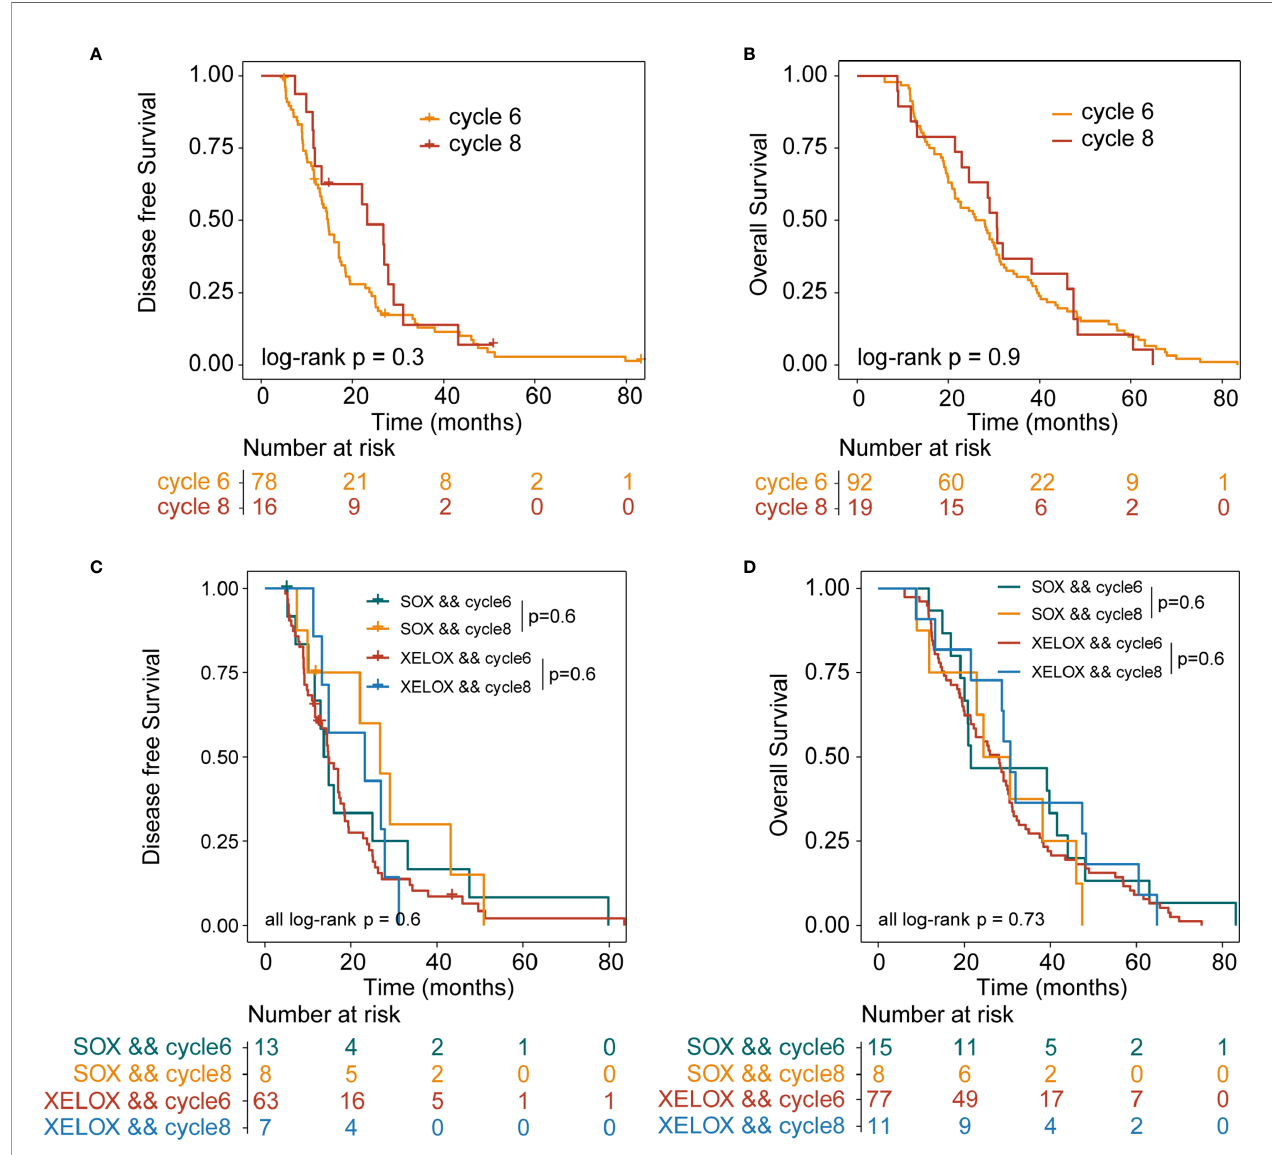
FIGURE 3 | Kaplan-Meier survival curves for disease-free survival (DFS) and overall survival (OS). DFS (A) and OS (B) analyses for patients with stage III gastric cancer who received six or eight cycles of chemotherapy, irrespective of whether they underwent XELOX or SOX regimens. DFS (C) and OS (D) analyses for patients with stage III gastric cancer who received six or eight cycles of chemotherapy, taking the speci fi c regimen into account. XELOX, Capecitabine plus oxaliplatin; SOX, S-1 plus